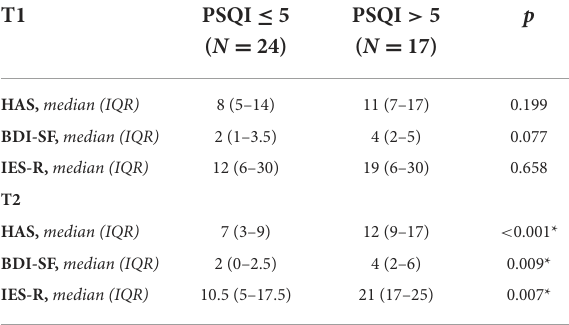
TABLE 6 Median HAS, BDI-SF and IES-R scores in patients with normal ( ≤ 5) vs abnormal ( > 5) PSQI total score at T1 and T2 study visits.